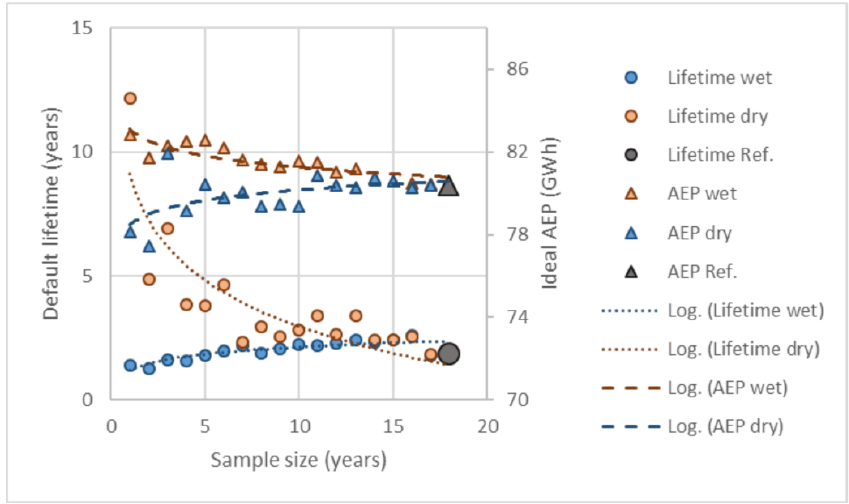
Figure 12. Default lifetime (primary y-axis) and ideal AEP (secondary y-axis) as a function of sample size for Wet (+2 standard deviations) and Dry ( − 2 standard deviations) on rain rate for 17 different samples sizes and for the Reference (Ref.) of 18 years for Hvide Sande and logarithmic trend lines. The ideal AEP as a function of sample size for ± 2 standard deviation rain rate was also presented in Figure 12 (note the secondary y-axis). The reference ideal AEP (grey triangle) was 80 GWh. The results show that higher AEP was found for very wet conditions (blue triangles) and lower AEP for dry conditions (red triangles). The ideal AEP